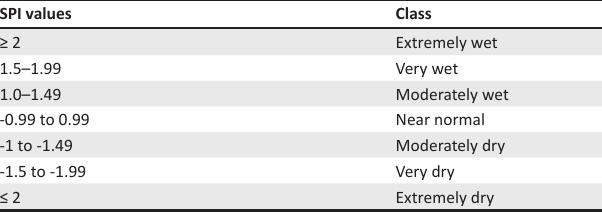
FIGURE 1: Map of Eswatini with agro-ecological zonation and the rainfall stations. TABLE 2: Drought classification based on Standard Precipitation